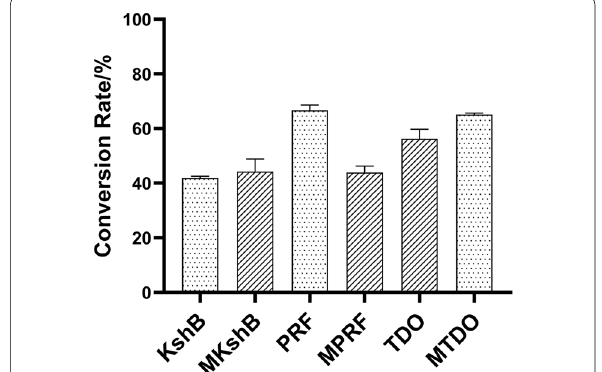
Fig. 1 Conversion rate of AD to 9OHAD. AD conversion rate of various reductases of KshB, PRF, TDO or mutants MKshB, MPRF, MTDO in KshA reductase catalytic reaction +